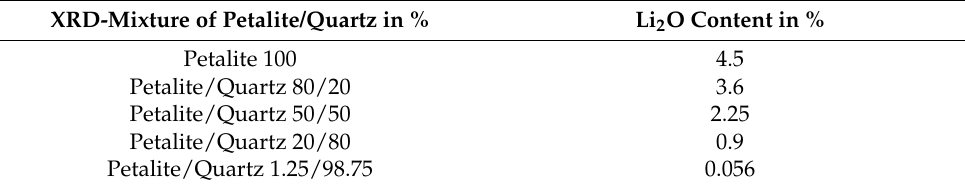
Table 3. Lithium oxide content as given from several selected petalite/quartz